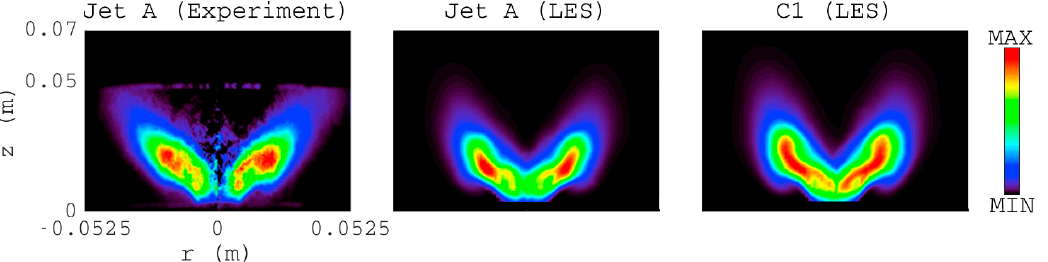
Figure 10. Time-averaged flame shape in the experiments (far left) and simulations (middle and right). Experimental results taken from [83].